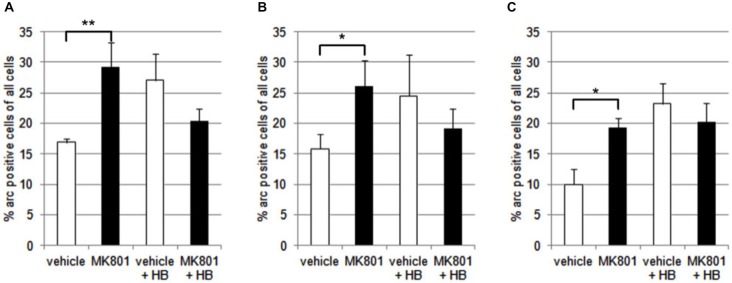
Overview of Arc expression in naïve animals or following spatial learning. Bar charts summarize Arc expression in naïve animals that were treated with vehicle or with MK801 4 weeks previously. In the CA1 region (A), the CA3 region (B) and dentate gyrus (C), basal Arc expression is significantly increased in MK801-treated animals compared to vehicle-injected controls. In a separate animal cohort, novel spatial exploration resulted in significant elevations of neuronal Arc expression in the hippocampus of vehicle-treated animals compared to their naïve state. This was not the case for MK801-treated animals. Here, no difference was detected in Arc gene expression after novel spatial exploration. *p < 0.05, **p < 0.01.